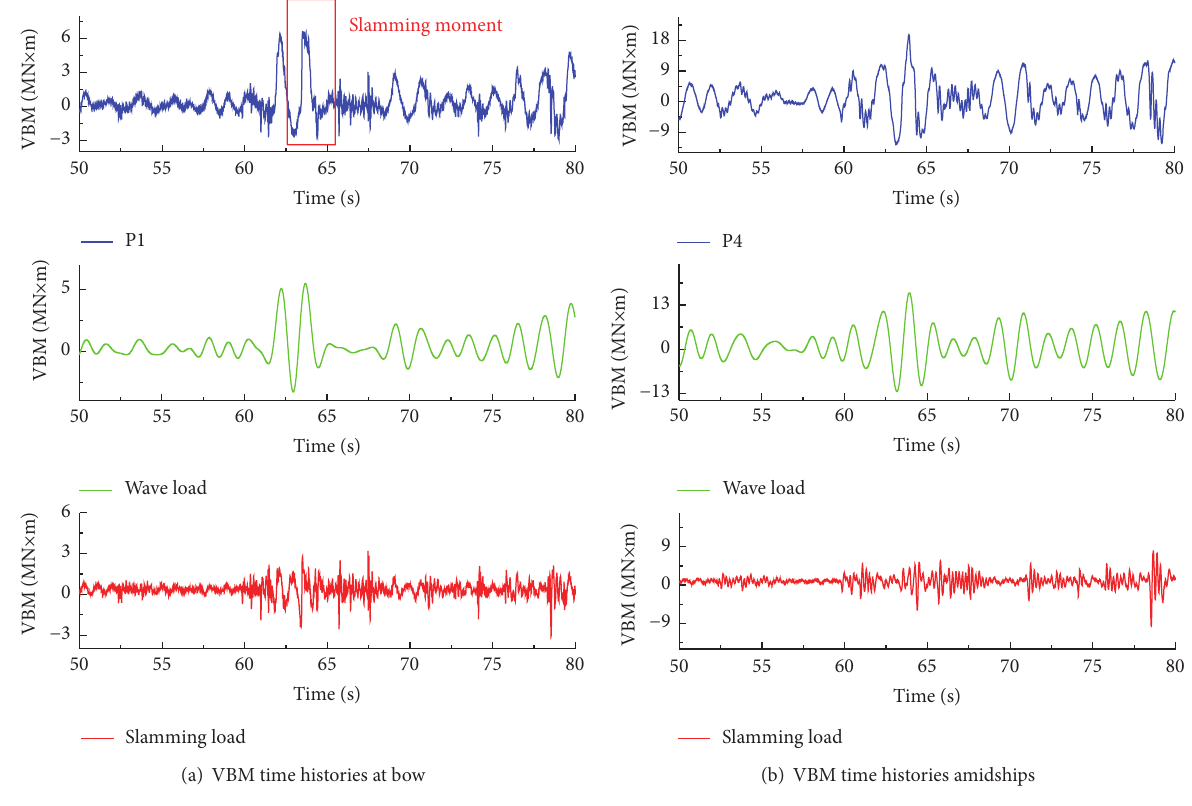
Figure 40: VBM time histories at slamming moment.